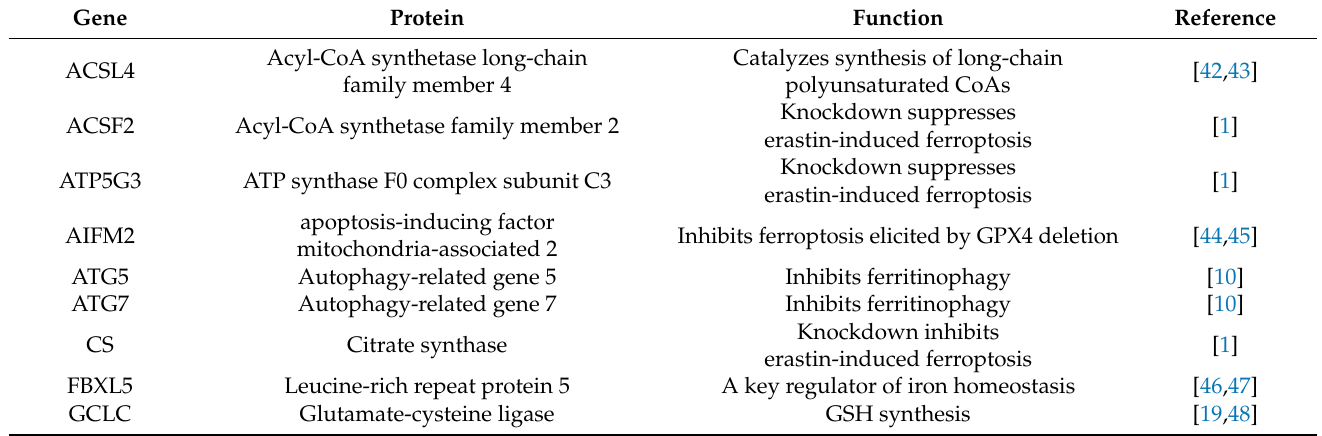
Table 2. Genes and proteins identified in